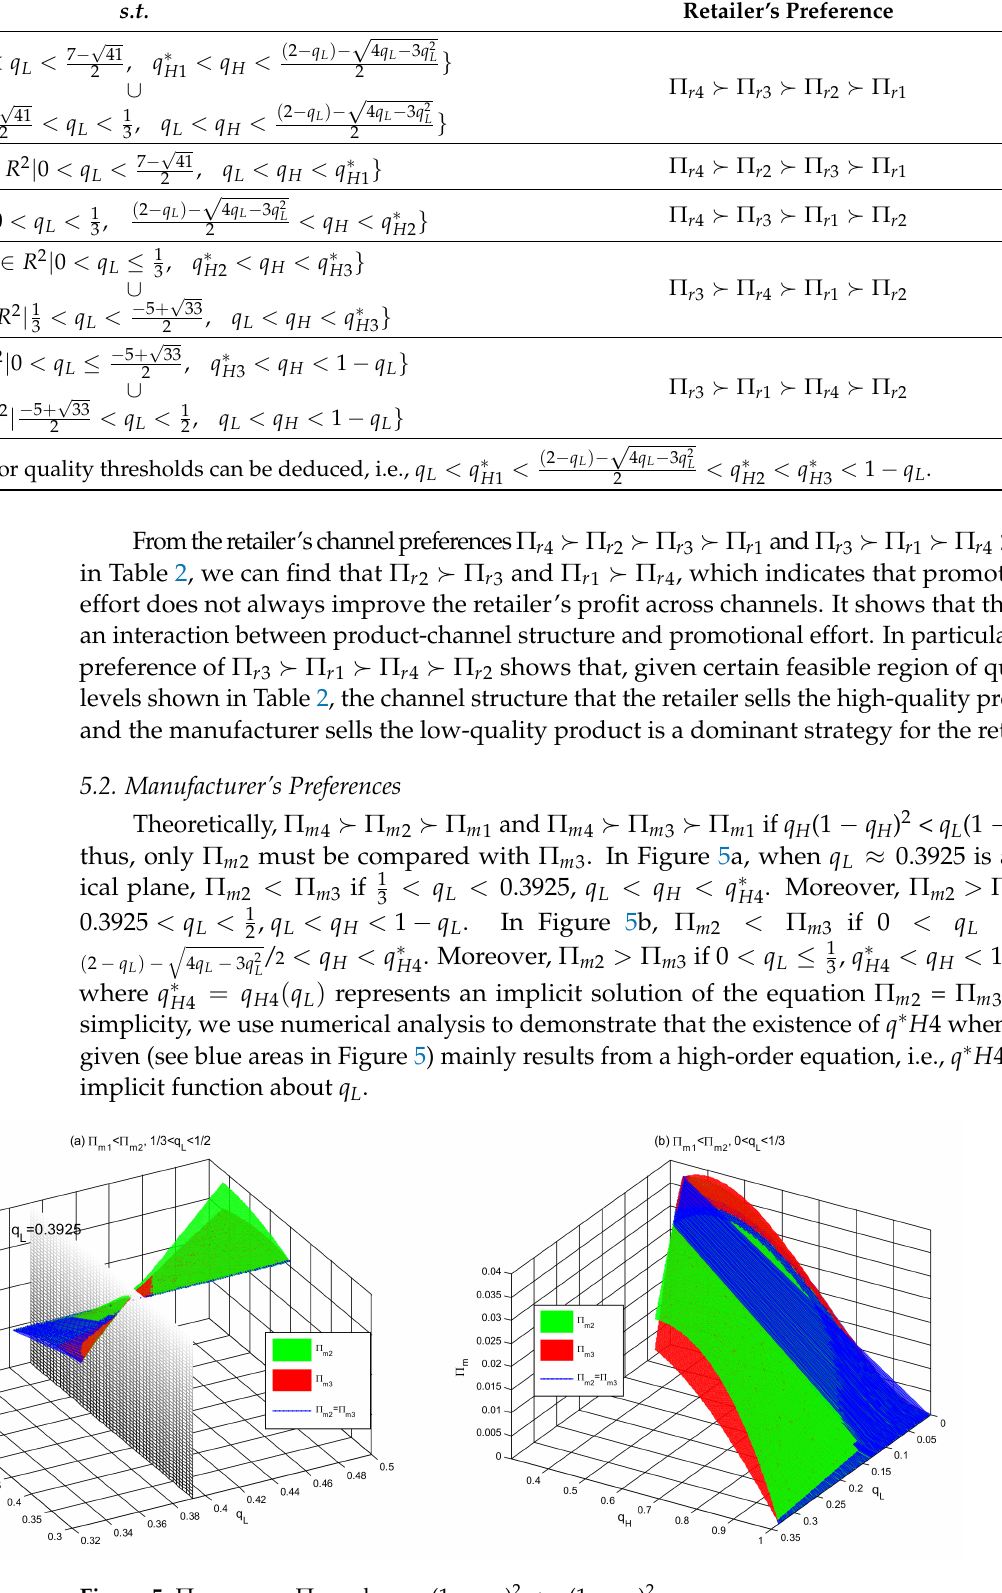
Table 2. Retailer’s preference for channel structures in different mass intervals. s.t.